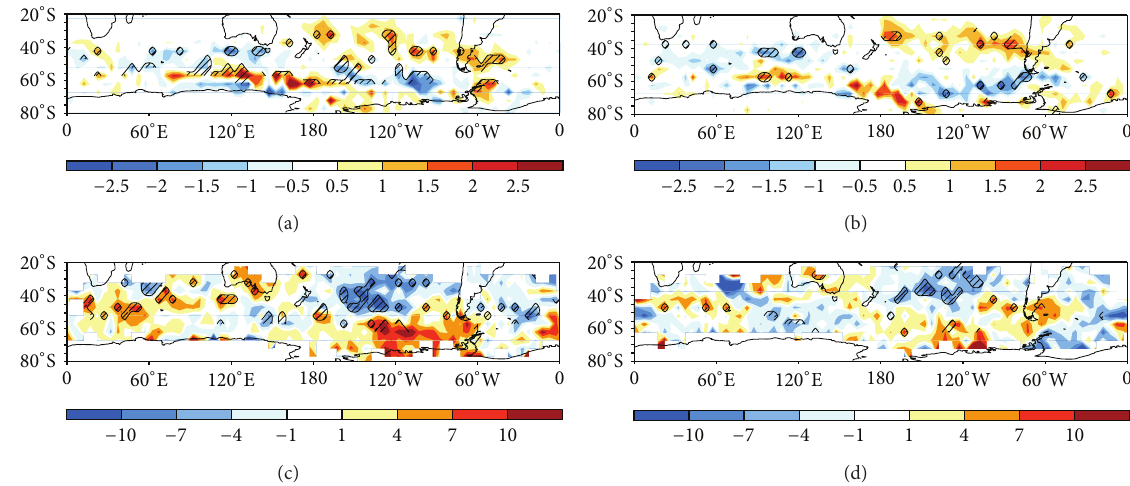
Figure 3: SH winter (JAS) El Ni˜no-La Ni˜na cyclone track frequency composite for (a) NCEP1 5801, (b) like “a” but for ERA40 5801. Units number of cyclones. Hatched areas are significant at 90% for 2-tailed 𝑡 -test. (c) SH winter (JAS) El Ni˜no-La Ni˜na cyclone track intensity composite for NCEP1 5801, (d) like “c” but for ERA40 5801. Units: hPa. Hatched areas are significant at 90% for 2-tailed 𝑡 -test.